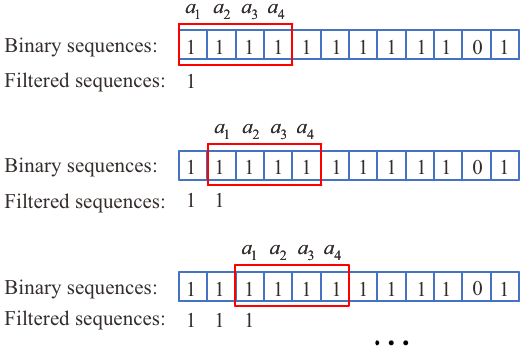
Figure 9. Filtering process using sliding window.